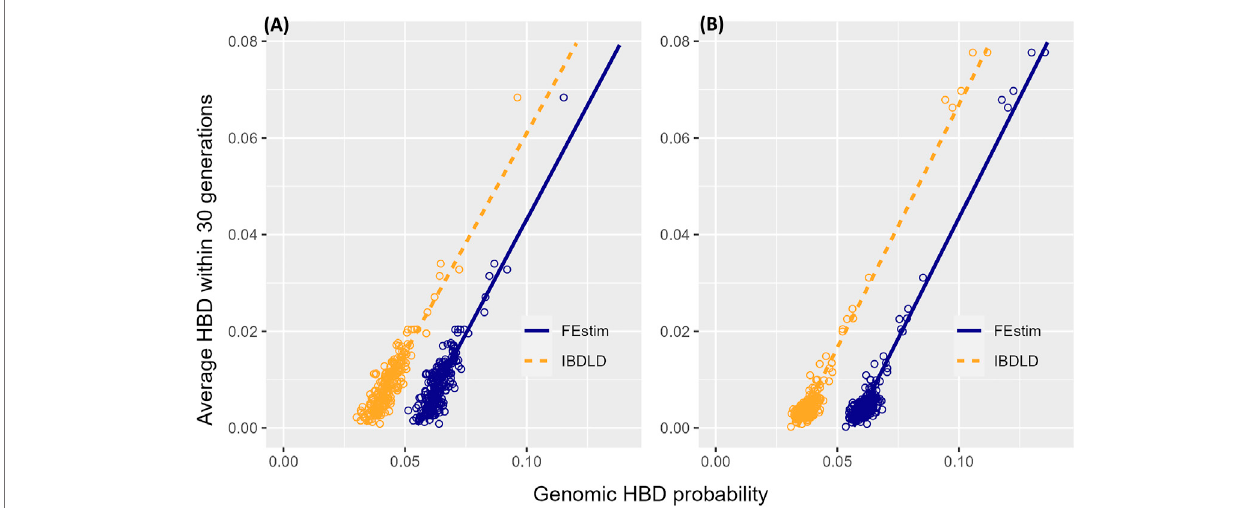
FIGURE 5 | Genomic- and genealogical/coalescent-based homozygosity by descent (HBD). Scatter plots with fi tted regression lines of the average (across simulationreplicates)HBDprobabilitiesestimatedfromtheobservedstudyandcoalescent/genegenealogiesandfromthesimulatedgenomicsegments(byFEstimand IBDLD) for (A) the SLSJ study and (B) the Montreal